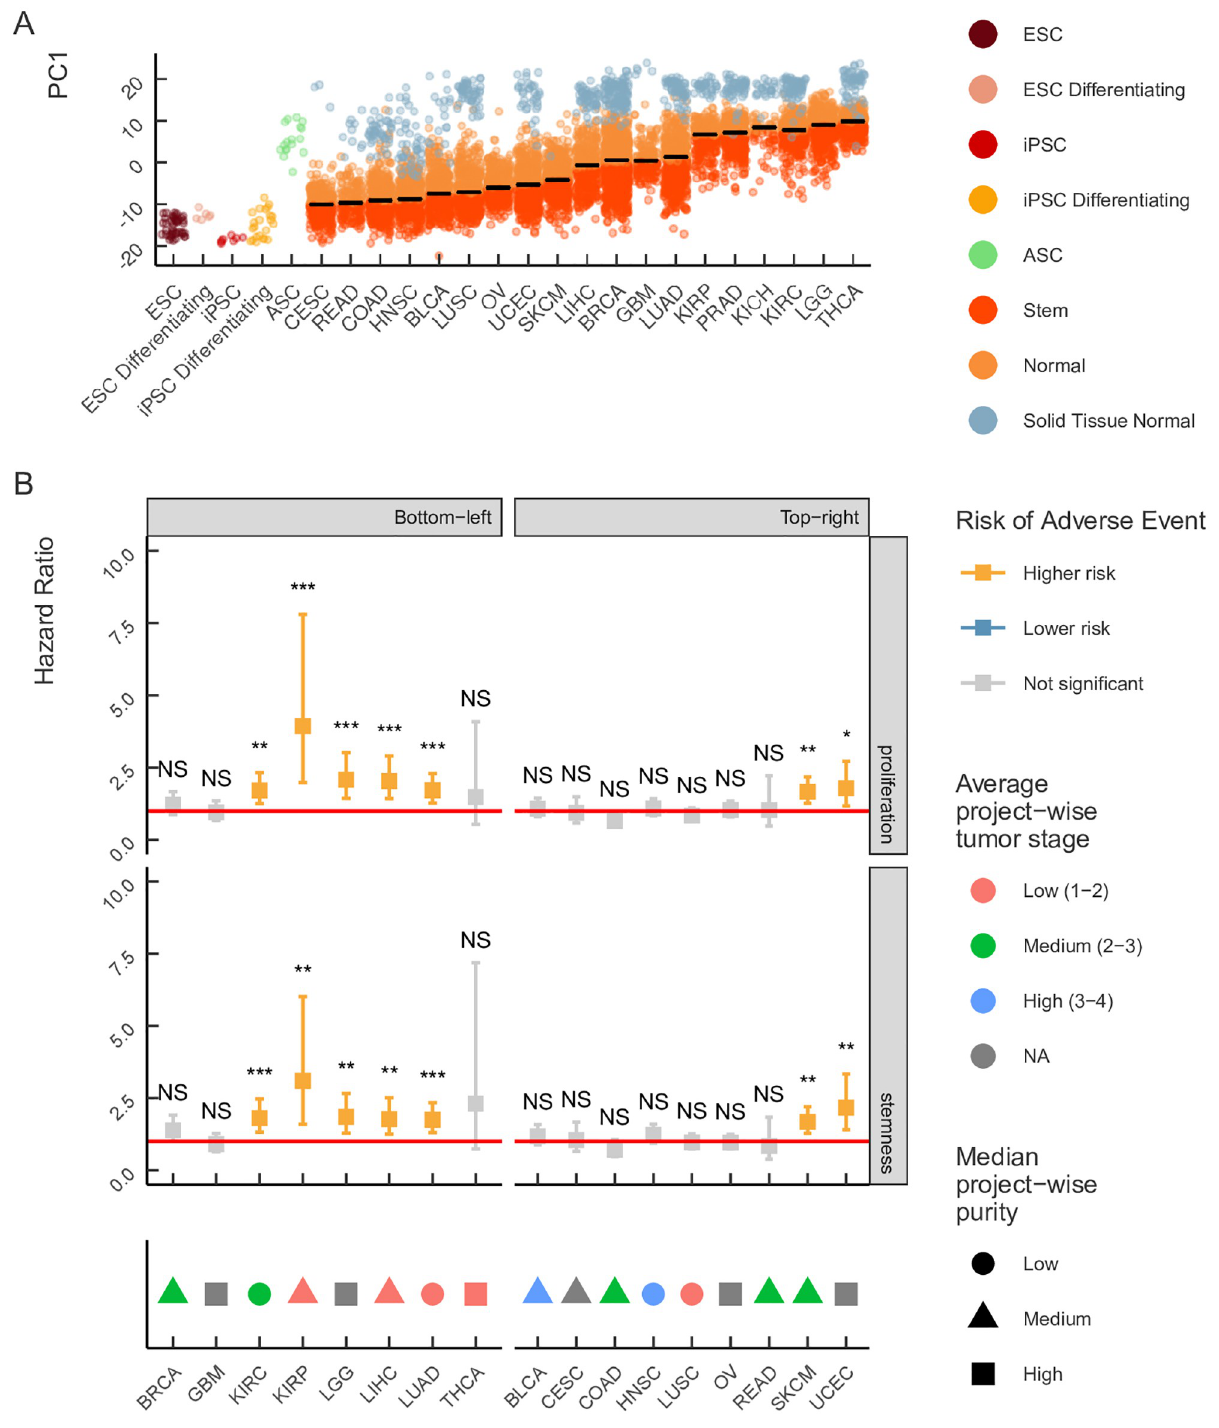
Fig 5. Intertumor heterogeneity of stemness and proliferation signatures. (A) Stem and Normal clusters specific to each tumor type are defined by the location of a sample relative to the median PC1 value across all samples of the given tumor (plotted as horizontal black lines). Samples above (below) the median are assigned to the Normal (Stem) cluster, respectively. (B) Hazard ratios for the comparison of patient survival in Stem and Normal clusters in two sample groups (top-right and bottom-left in Fig 4) with respect to stemness and proliferation intensity. Error bars denote 95% confidence intervals. Tumor types are annotated at the bottom according to the average tumor stage and the median tumor purity. Codes for statistical significance reported are as follows: NS − p-value > 0.05, � − 0.01 < p-value < 0.05, �� − 0.001 < p-value < 0.01, ��� − p-value < 0.001. The notation for cancer types as in Fig